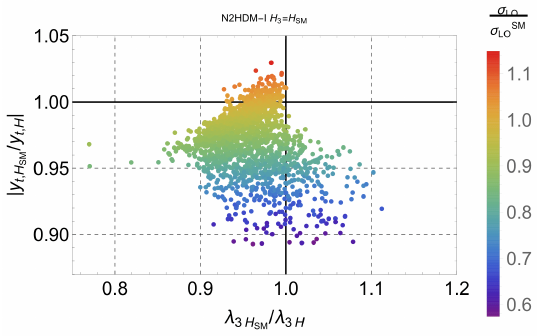
Figure 10 . N2DHM-I with H 3 ≡ H SM : cross section values normalized to the SM value (color code) as function of the top-Yukawa and trilinear Higgs self-couplings of H respective SM values. A factor of two is applied to the LO cross section to roughly account for the QCD corrections.